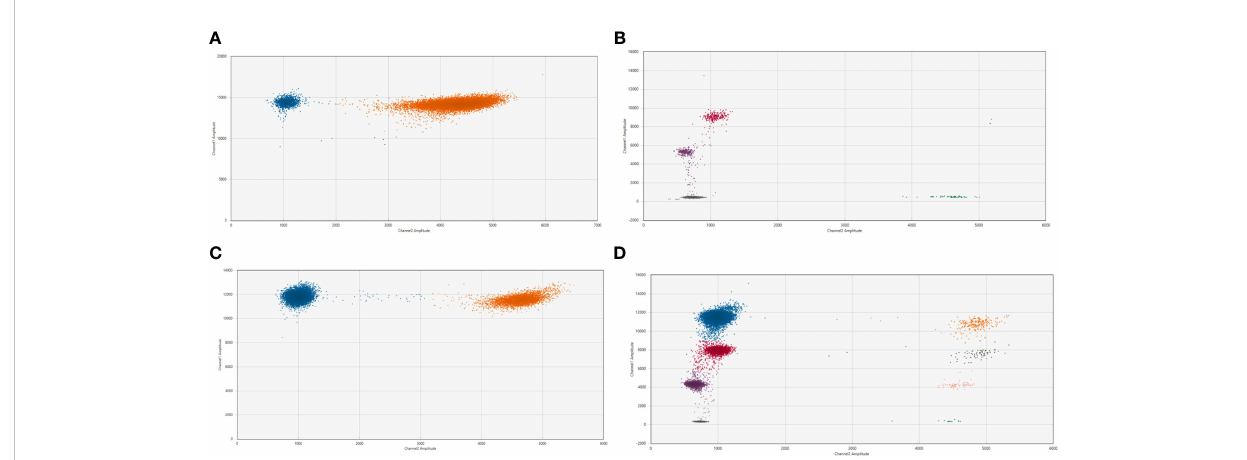
FIGURE 3 2D plot from the ddPCR assay for NB2050 with 2 patient-speci fi c breakpoints (A) . cfDNA from the diagnostic plasma sample (total cfDNA input can not be determined due to overload of the droplets) (B) . positive control with DNA from FFPE material from the primary tumor (total cfDNA input 1.7 ng/well). (C) Dilution of diagnostic plasma 50 times and (D) . 500 times Blue dots; droplets positive for both patient-speci fi c breakpoint (FAM channel) Green dots; droplets positive for Actin Beta (HEX channel) Pink dots; droplets positive for breakpoint Chr 2;2 nr 1 Purple dots; droplets positive for breakpoint Chr 2;2 nr 2 (with 450 nM and 125 nM primer and probe concentrations, respectively) Orange dots; droplets positive for both breakpoints and Actin Beta Black dots; droplets positive for breakpoint nr 1 and Actin Beta Salmon-colored dots; droplets positive for breakpoint nr 2 and Actin Beta Grey dot; droplets negative for both